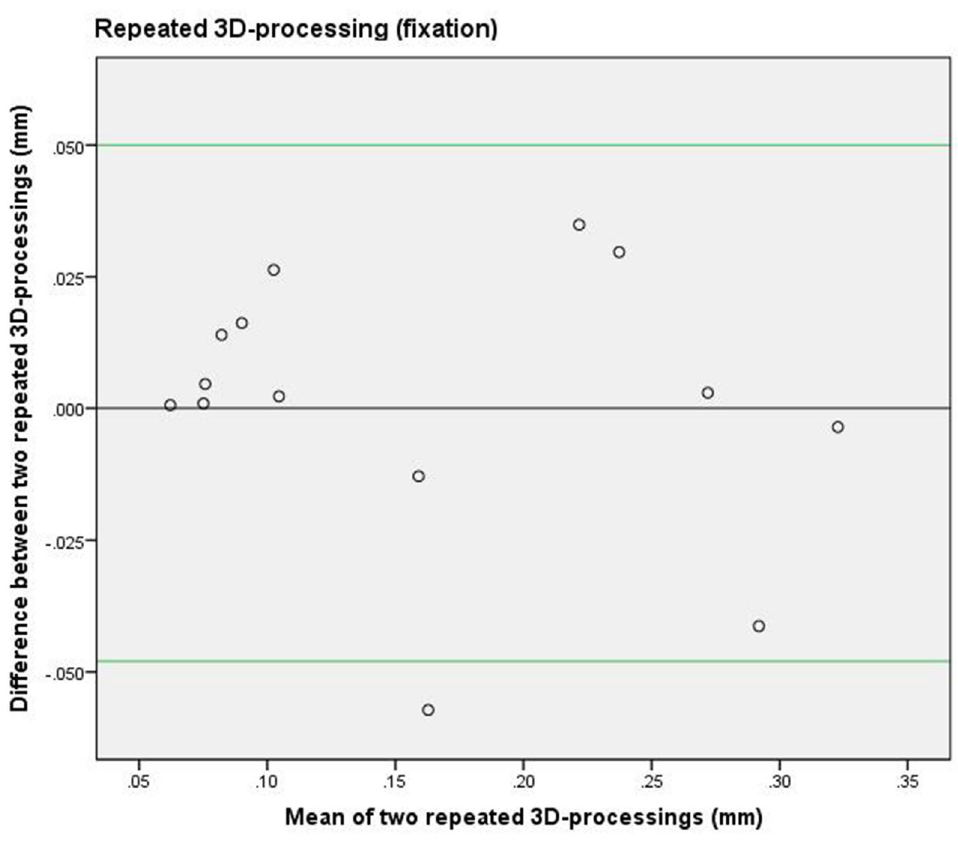
Figure 5. Bland Altman plot of repeated data processing (fixation). The 3D-data processing was repeated for the second minute-interval scans and comprised the cross section of the lateral iris of the left eye during fixation. The green lines represent the upper and lower limits of agreement between the two 3D-data processing